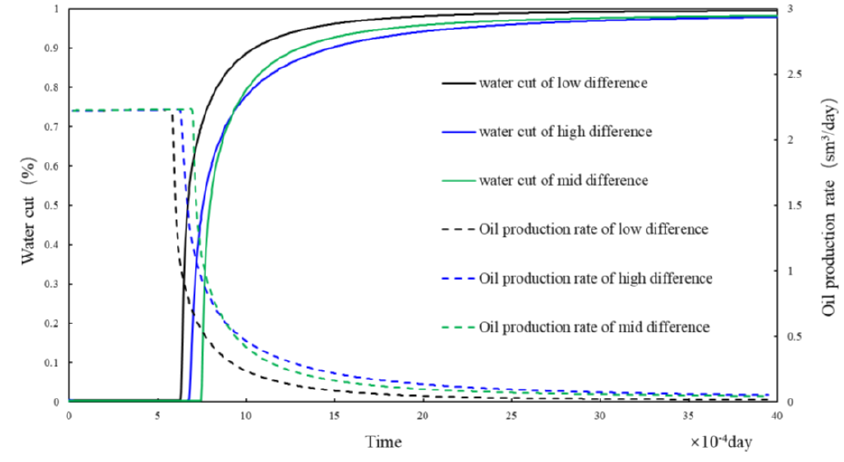
Figure 7. Water cut and daily oil production of different anisotropic relative permeability.